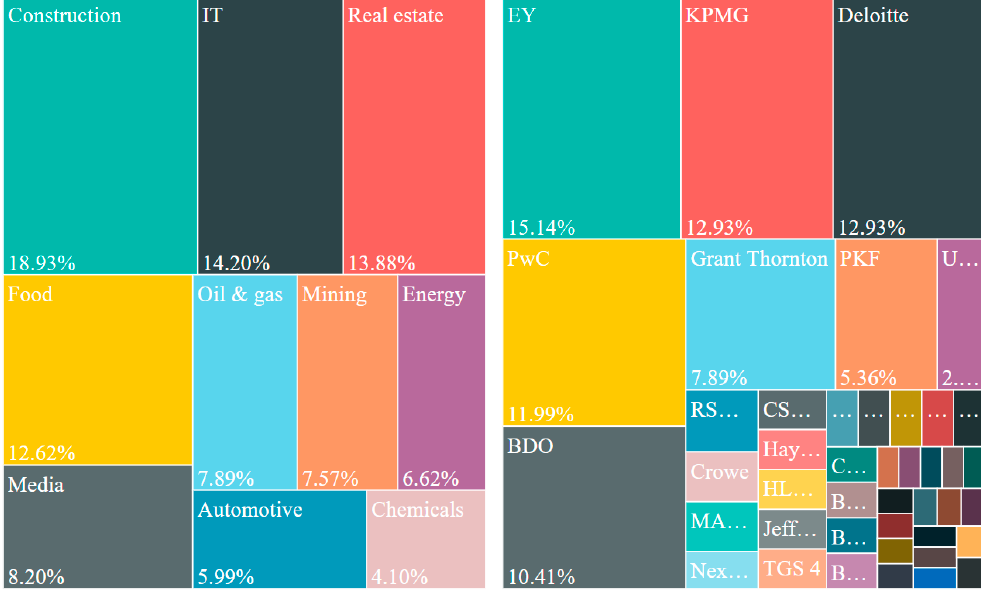
Figure 3. Structure of the tested sample in terms of WIGs and the auditors (in %). Source: own elaboration based on analyzed data.